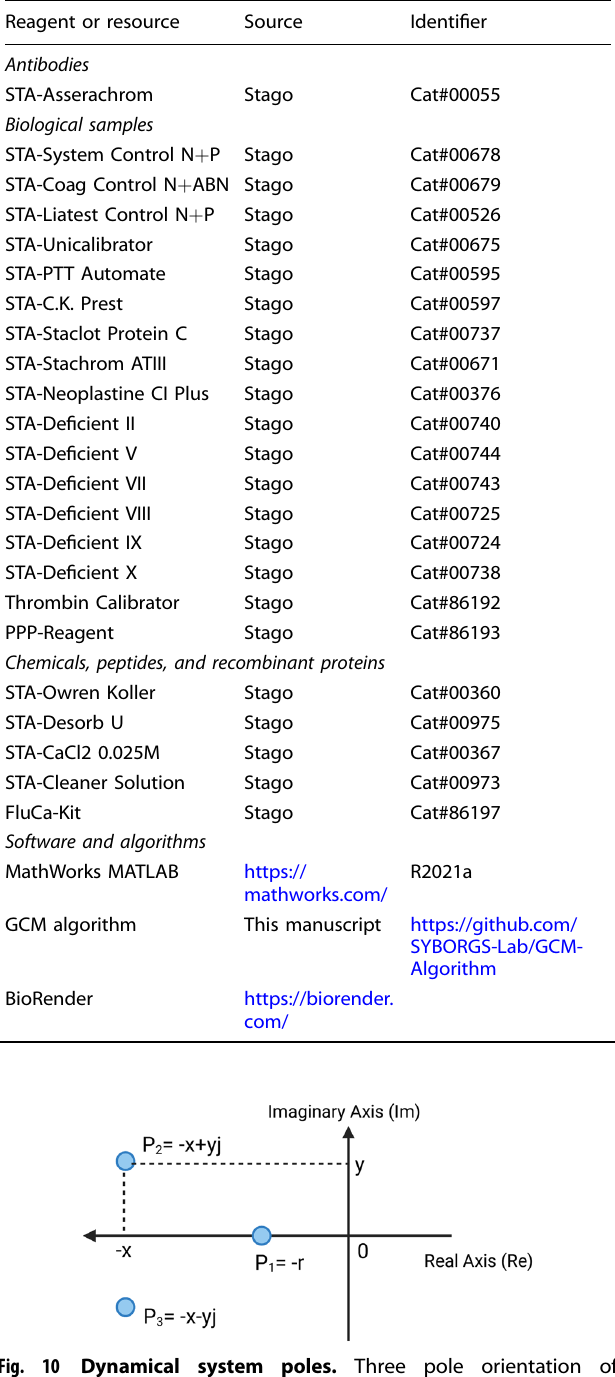
Table 1. Key resource table.